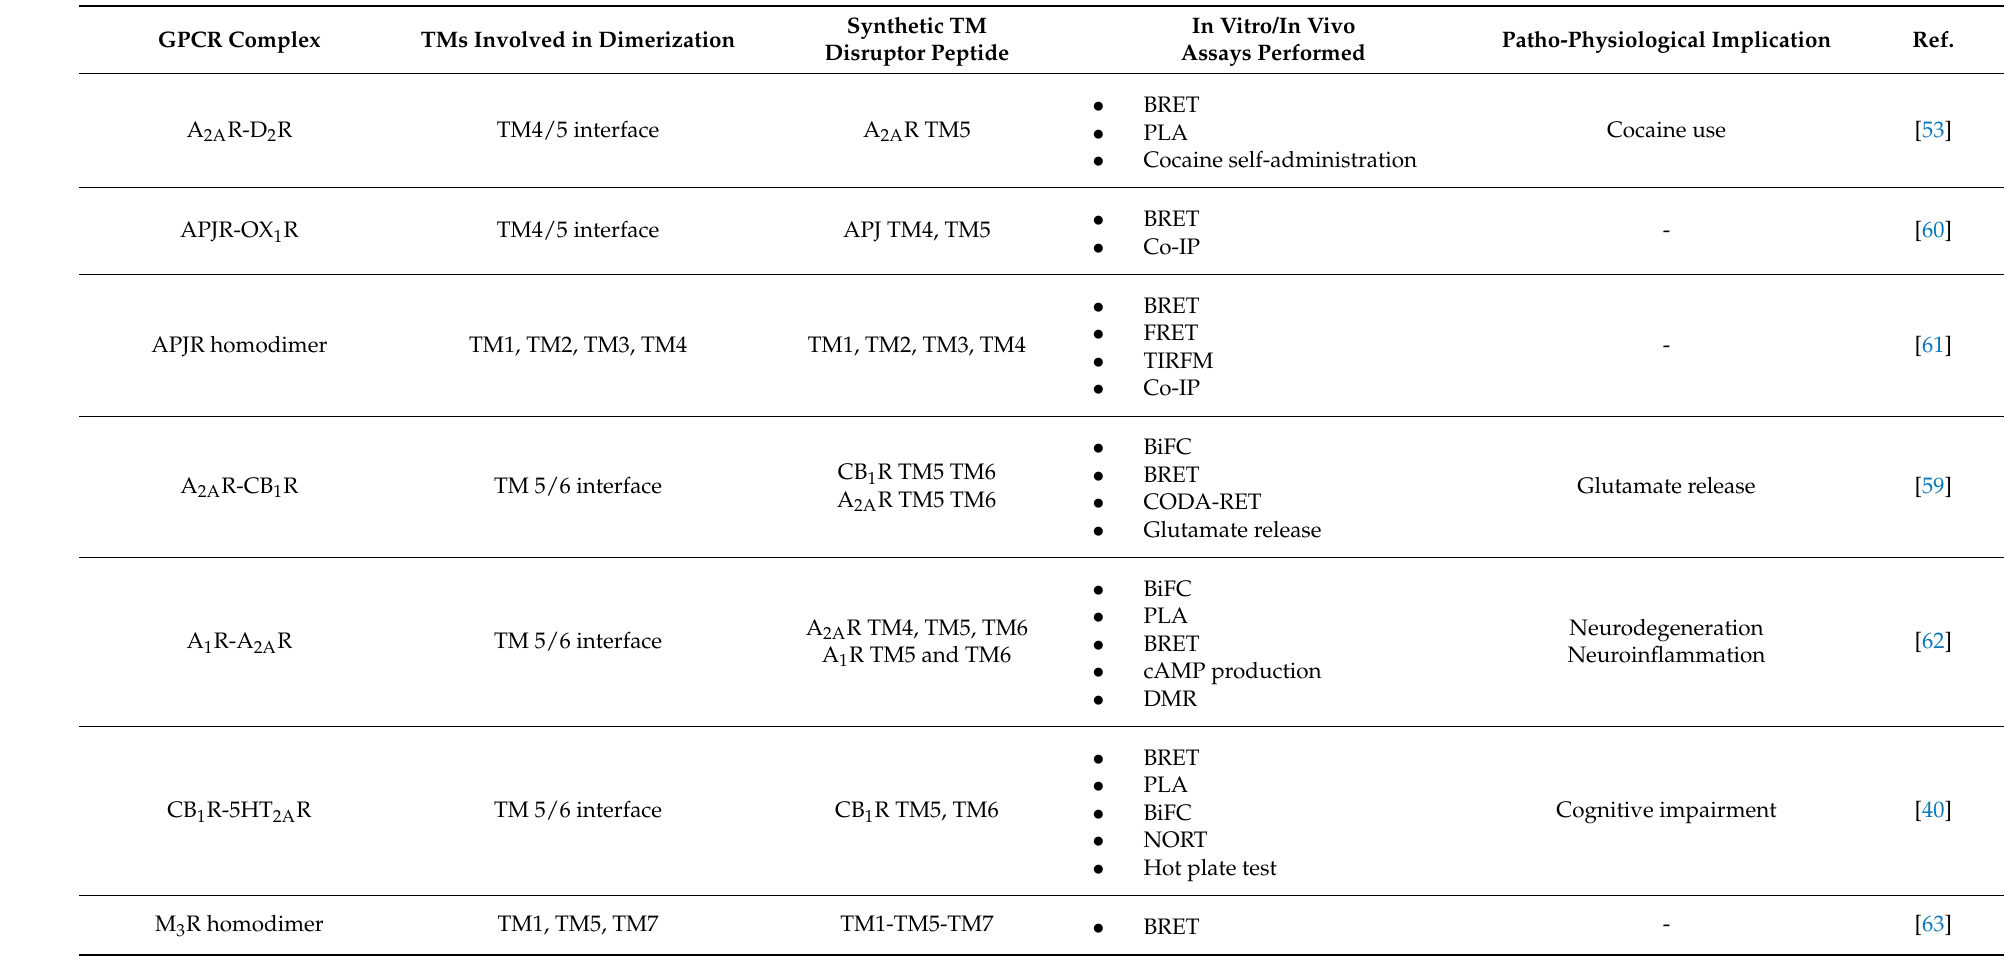
Table 1. GPCR complexes disrupted by synthetic TM